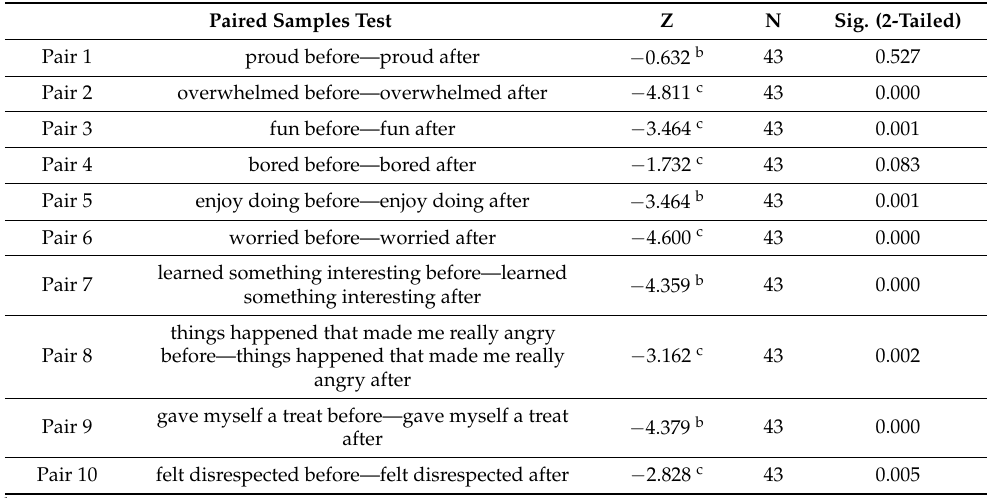
Table 7. Pemberton happiness index PHI II before and after the forest therapy experience—display of paired